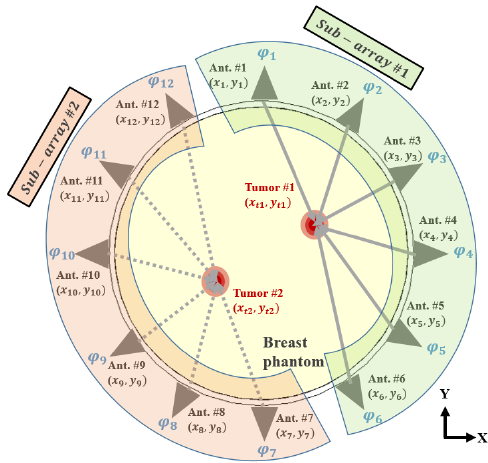
Figure 7. Configuration of the six-element antenna sub-array focusing system for two breast tumors. The positions of two tumor cells at (15,10) mm and ( − 15, − 10) mm on the xy- plane are presented in Figure 8a. Antennas #1–#6 transmit microwaves to tumor #1, while #7–#12 transmit EM energy to tumor #2 in the simultaneous cancer treatment regimen. The calculated input phases aimed to concentrate the E-field on the two tumors in different positions. However, the SAR patterns were formed at positions away from the desired locations, and an unwanted E-field was applied to the breast phantom, as shown in Figure 8b. Although each antenna sub-array focused the electric field on different targets (tumors #1 and #2), incorrect field synthesis occurred outside of the target area due to the interactions of the E-fields passing through the tumor cells. In addition, unwanted E-field synthesis was observed due to interferences from the TSA antennas, which were facing each other. To minimize unwanted interference and provide a correct target positions, the phase compensation technique will be discussed in the next section.